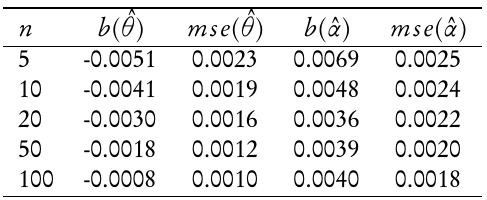
θ = 0.75 , m = 20 , and α = 0.25 .